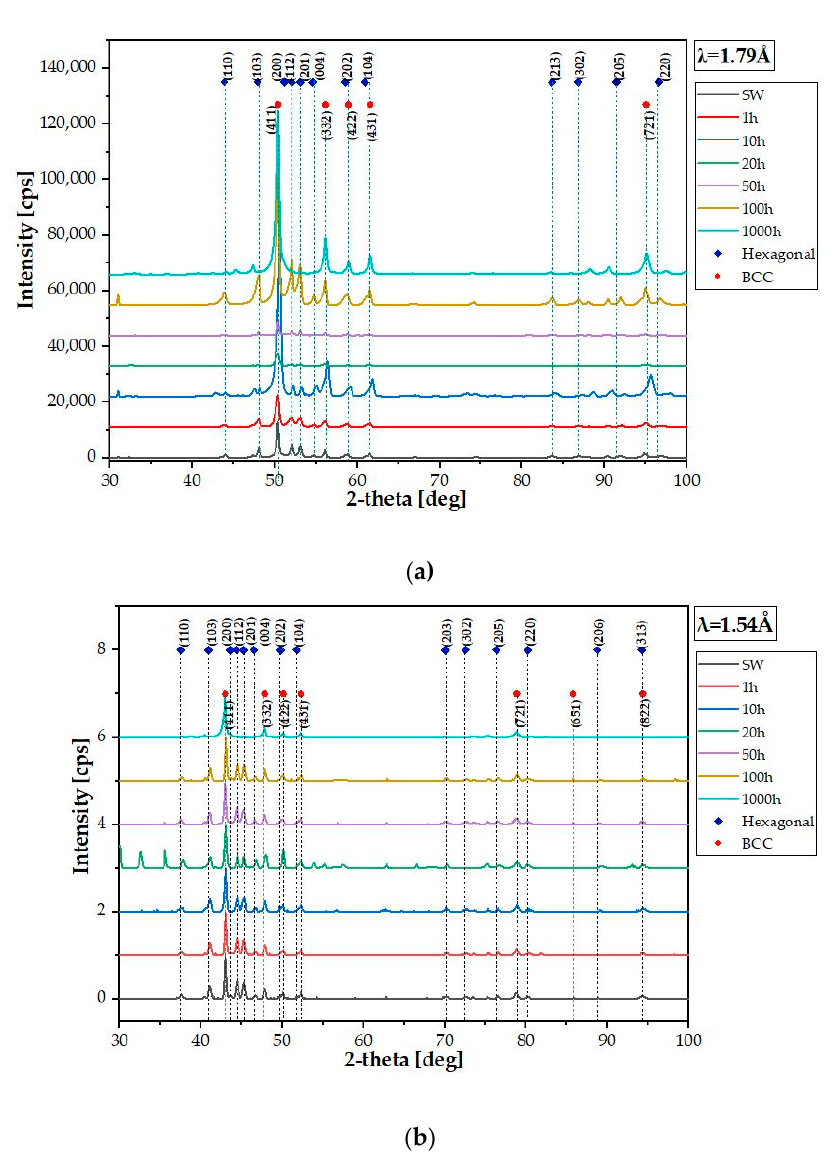
Figure 10. TiCoCrFeMn alloy diffractograms after different annealing times for the two used X-ray wavelengths, Co lamp ( a ), Cu lamp ( b ).